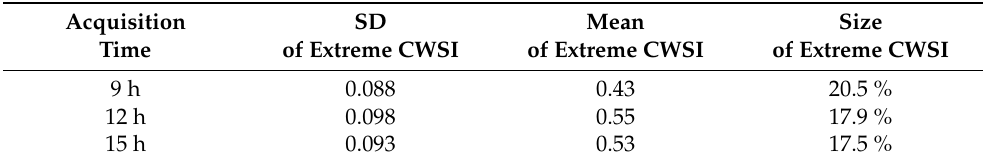
Table 4. Statistics of the extreme adaptive CWSI over all the irrigation regimes at three times of the